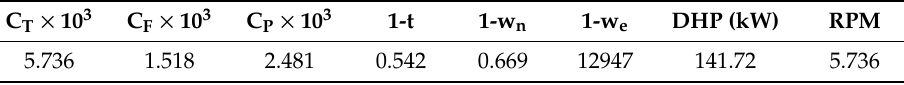
Table 11. Calculated propulsive characteristics at ship scale.